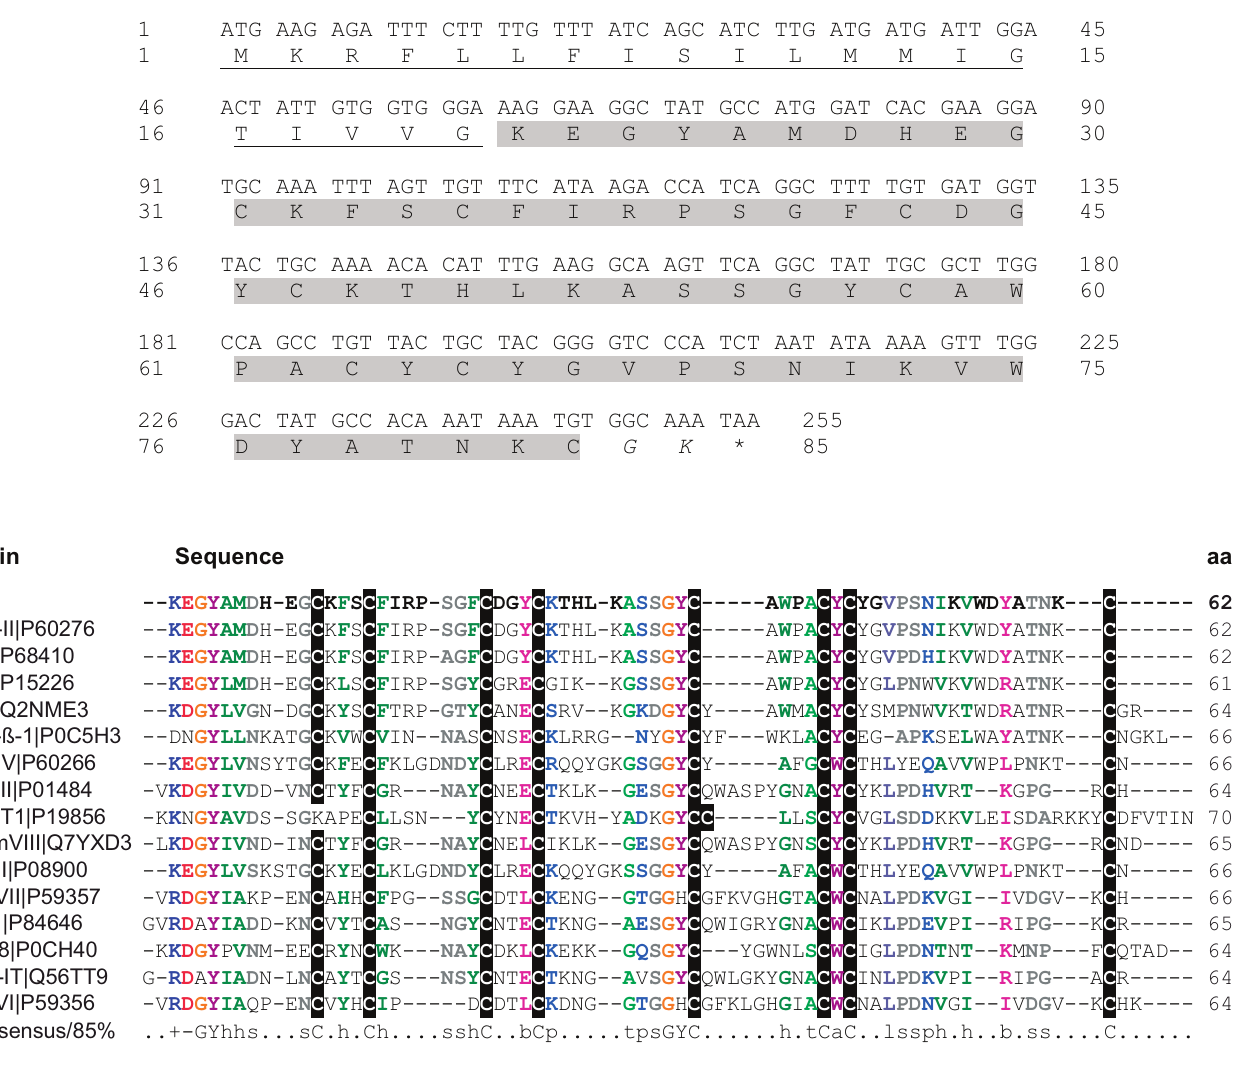
Fig 2. Tf2 sequence and alignment with scorpion Na v channel toxins. (A) The nucleotide sequence of Tf2 was obtained by HiSeq (Illumina, USA). Signal peptide is underlined, mature peptide is highlighted in gray, and the amidation set point is marked in italic. (B) Multiple sequence alignment of Tf2 with other Na v channel toxins. Toxins are presented by their short names and UniProt KB codes. Capital letters denote amino acids. Lower-case letters denote: h, hydrophobic; s, small; b, big; p, polar; t, tiny; a, aromatic; l, aliphatic. Positive (+) and negative (-) amino acid residues that are part of the consensus sequence are also colored. Cys residues are shaded in black. aa means amino acid residues, and %Id is the percentage of sequence identity with Tf2.